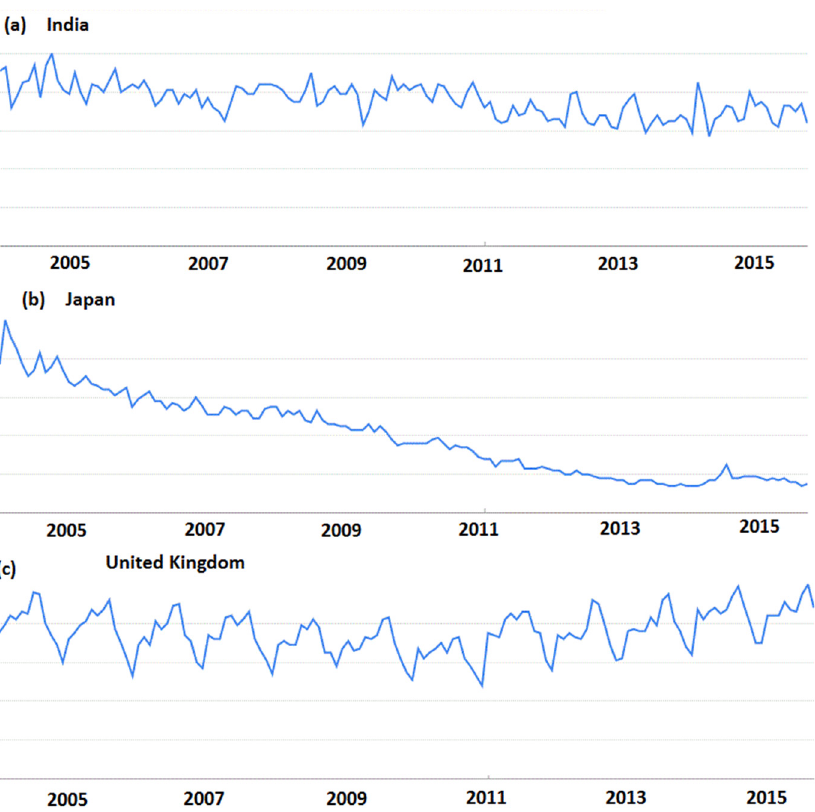
Figure 6. Temporal trend (2004–September 2015), as of September 2015, in Google searches by the general public for “forest” in ( a ) India; ( b ) Japan; and ( c ) the UK.